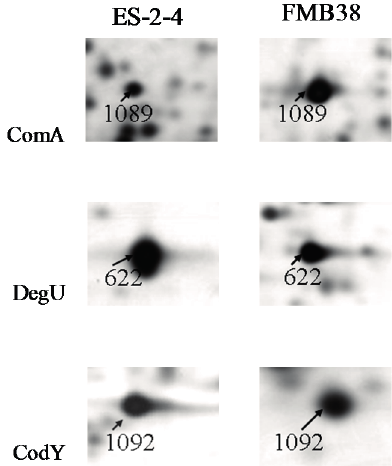
Figure 4. Enlargement of ComA, DegU, and CodY protein spots on 2-DE gels.